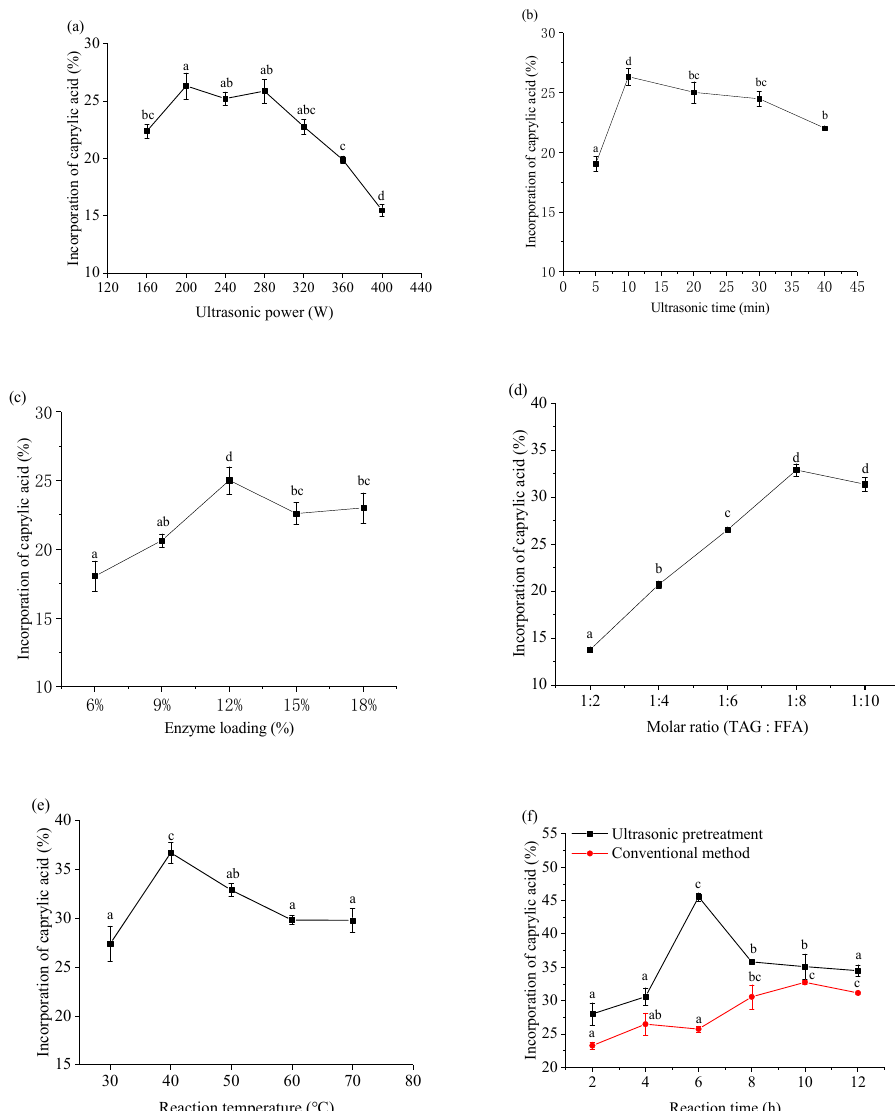
Figure 2. Optimization of reaction conditions for MLM (medium-, long- and medium-chain-type TAGs) structured lipids synthesis by enzymatic acidolysis in organic system assisted by bath ultrasonic pretreatment. Reaction conditions: ( a ), 10 min pretreatment time, 1:6 corn oil / CA molar ratio, 12% enzyme dosage, and 5 mL of hexane, 50 ◦ C; ( b ), 200 W ultrasonic power, 1:6 corn oil / CA molar ratio, 12% enzyme dosage, and 5 mL of hexane, 50 ◦ C;( c ), 200 W ultrasonic power, 10 min pretreatment time, 12% enzyme dosage and 5 mL of hexane, 50 ◦ C;( d ), 200 W ultrasonic power, 10 min pretreatment time, 12% enzyme dosage and 5 mL of hexane, 50 ◦ C;( e ), 200 W ultrasonic power, 10 min pretreatment time, 1:8 corn oil / CA molar ratio, 12% enzyme dosage, and 5 mL of hexane; ( f ), 200 W ultrasonic power, 10 min pretreatment time, 1:8 corn oil/CA molar ratio, 12% enzyme dosage, and 5 mL of hexane, 40 ◦ C. Different letters indicate significant differences.